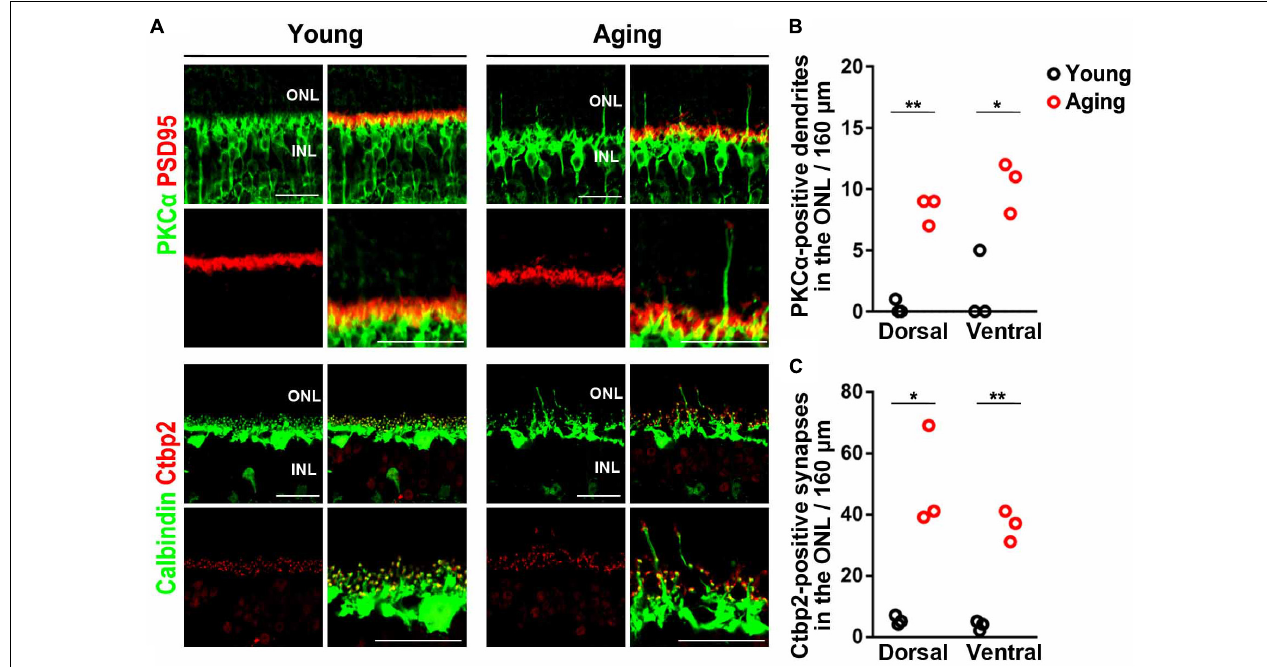
FIGURE 1 | Mislocalization of photoreceptor synaptic terminals observed in aging mouse retinas. (A) Retinal sections of the young adult and aging mice were immunostained using anti-PSD95, anti-Ctbp2, anti-Calbindin, and anti-PKC α antibodies. (B–C) Extended rod bipolar cell dendrites and ectopic photoreceptor terminals were counted. Student t -test (* p < 0.05, ** p < 0.01). Error bars, mean ± SD ( n = 3 mice). ONL, outer nuclear layer; OPL, outer plexiform layer; INL, inner nuclear layer. Scale bars, 25 µ